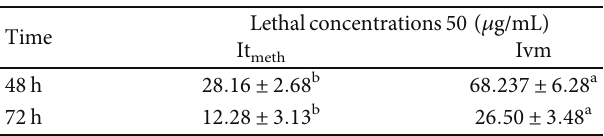
Figure 1: Lethal e ff ect of the methanolic extract (a) and Ivermectin (b) concentrations on Onchocerca ochengi after 48 h and 72 h of incubation. It : Methanolic extract of Indiofera tinctoria ; Ivm: ivermectin. meth Table 2: Lethal concentrations values ( LC ) of methanolic crude 50 extract and